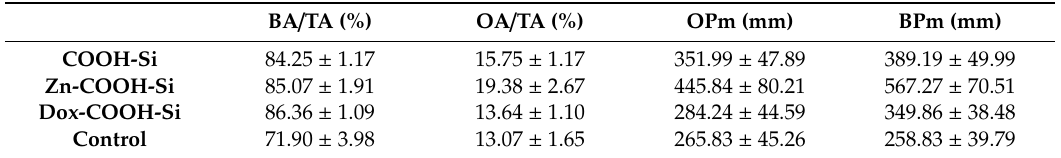
Table 3. Histomorphometric data acquired by fluorescence with calcein, within the new bone created at the region of interest (Mean ± Standard Error).